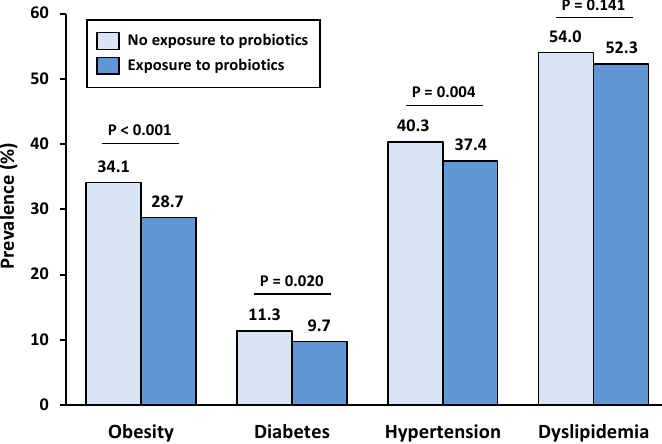
Figure 1. Prevalence of obesity, diabetes, hypertension, and dyslipidemia, according to probiotic exposure. Table 2. Odds ratios of disease in subjects exposed to probiotics compared to non-exposed subjects. Unadjusted,